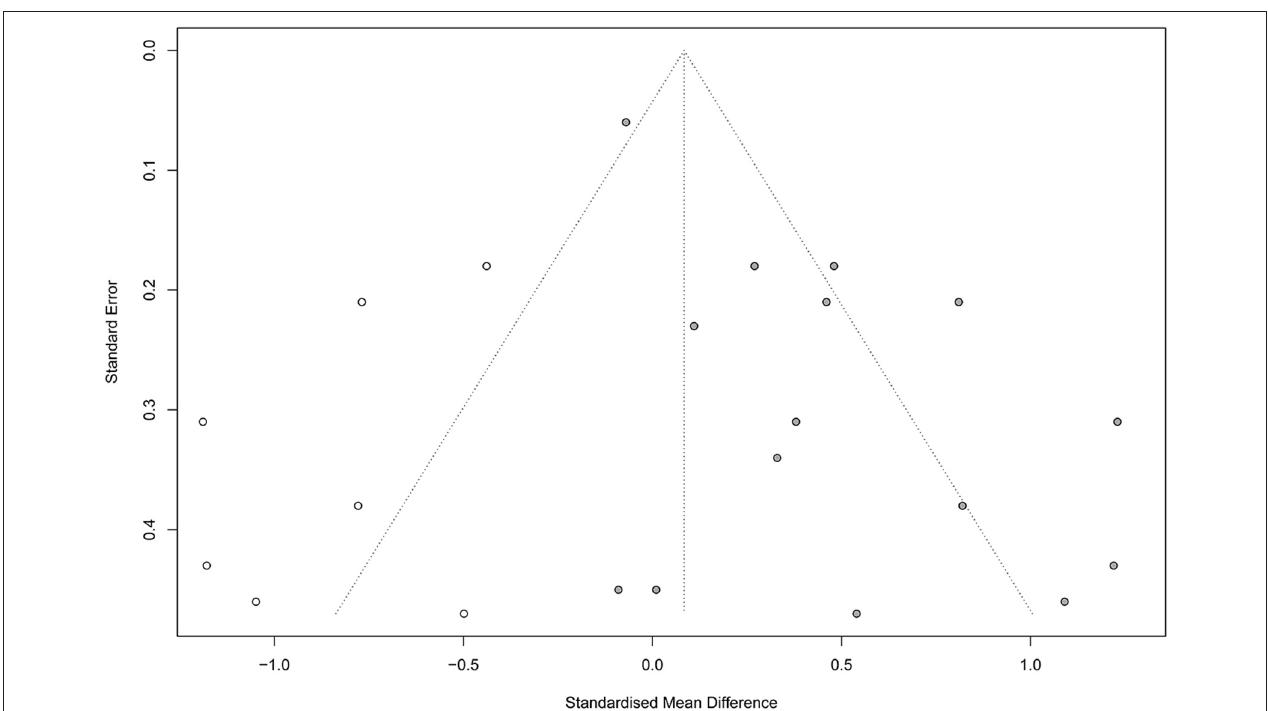
FIGURE 6 | Funnel plot with trim-and-fill method. Number of studies combined: k = 22 (with seven added